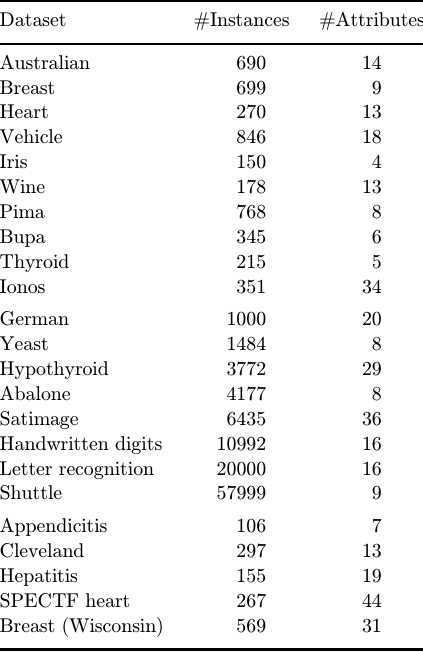
Table 1. Popular, large and medical